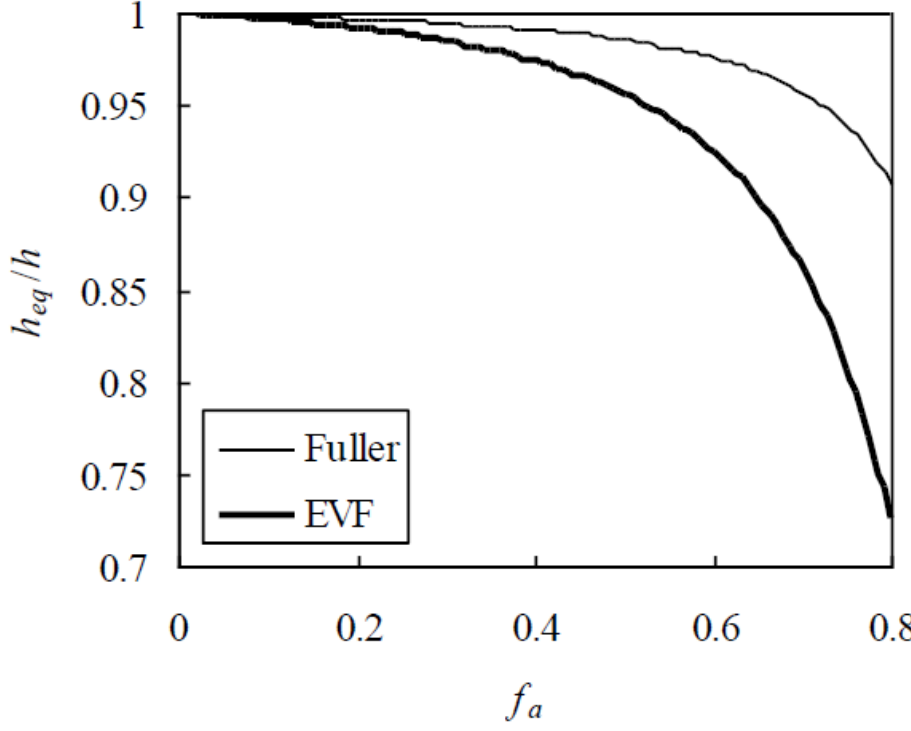
Figure 3. Effect of aggregate gradation on h eq /h. Figure 3. E ff ect of aggregate gradation on h eq /